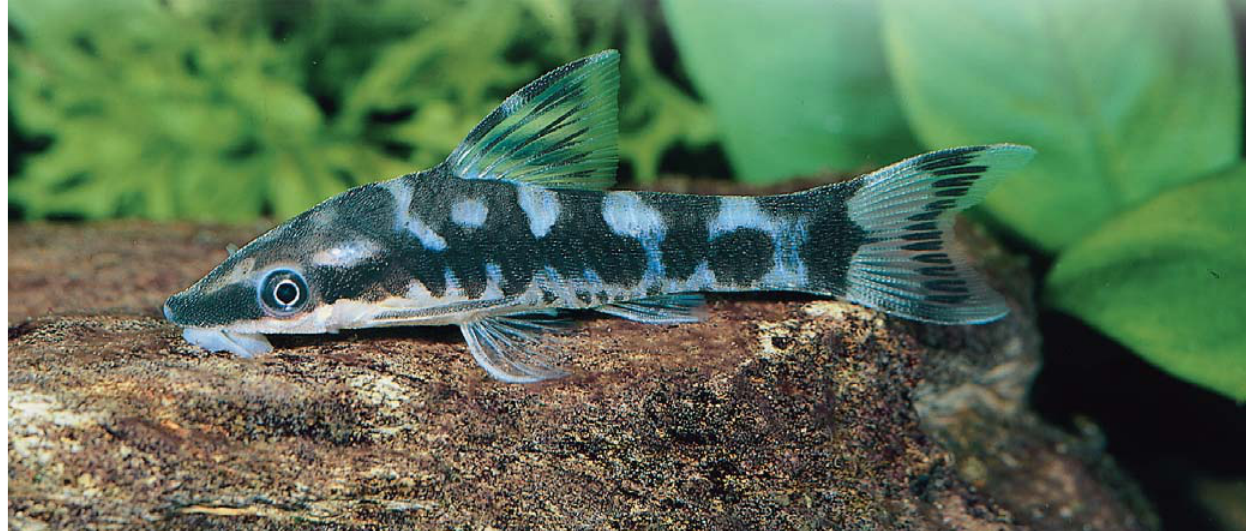
Fig. 4. Live specimen of Otocinclus cocama , collected in Peru in 2000; not preserved. Photo by Ingo